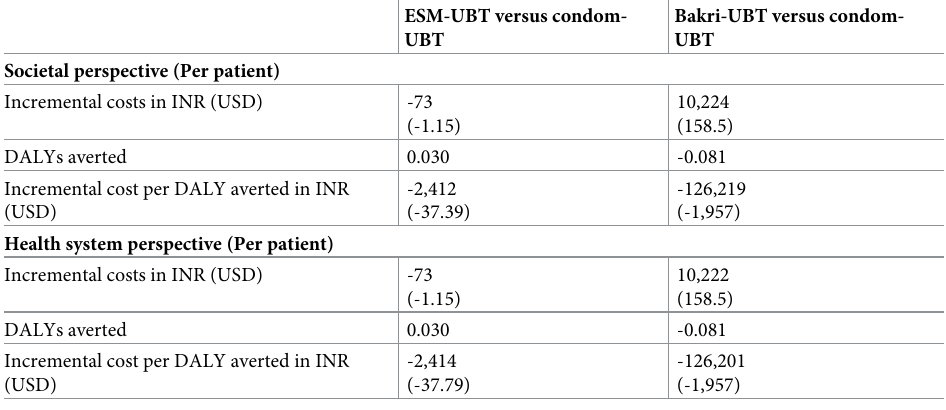
Table 3. Incremental costs, consequences and cost-effectiveness of UBT intervention in atonic PPH